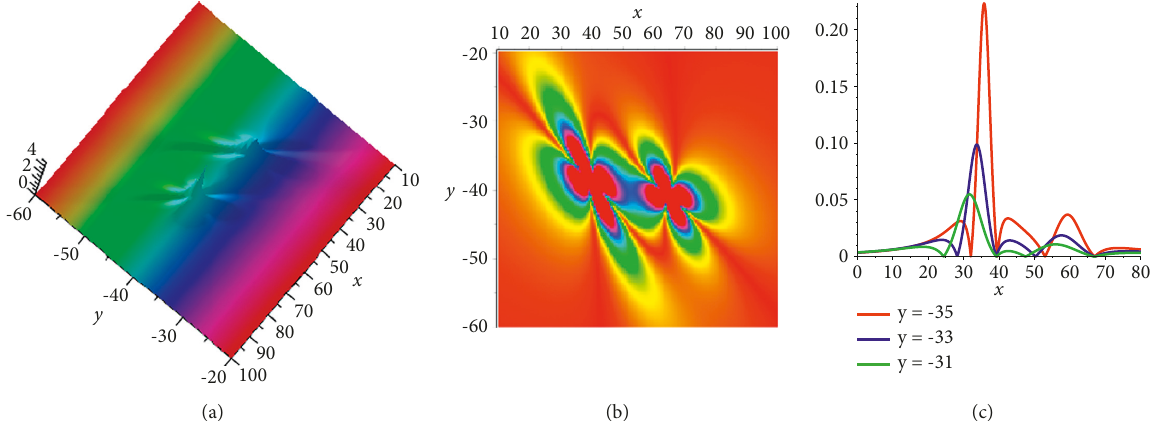
Figure 8: Plot of equation (50) by taking a � c � d � e � c (c) f 3.